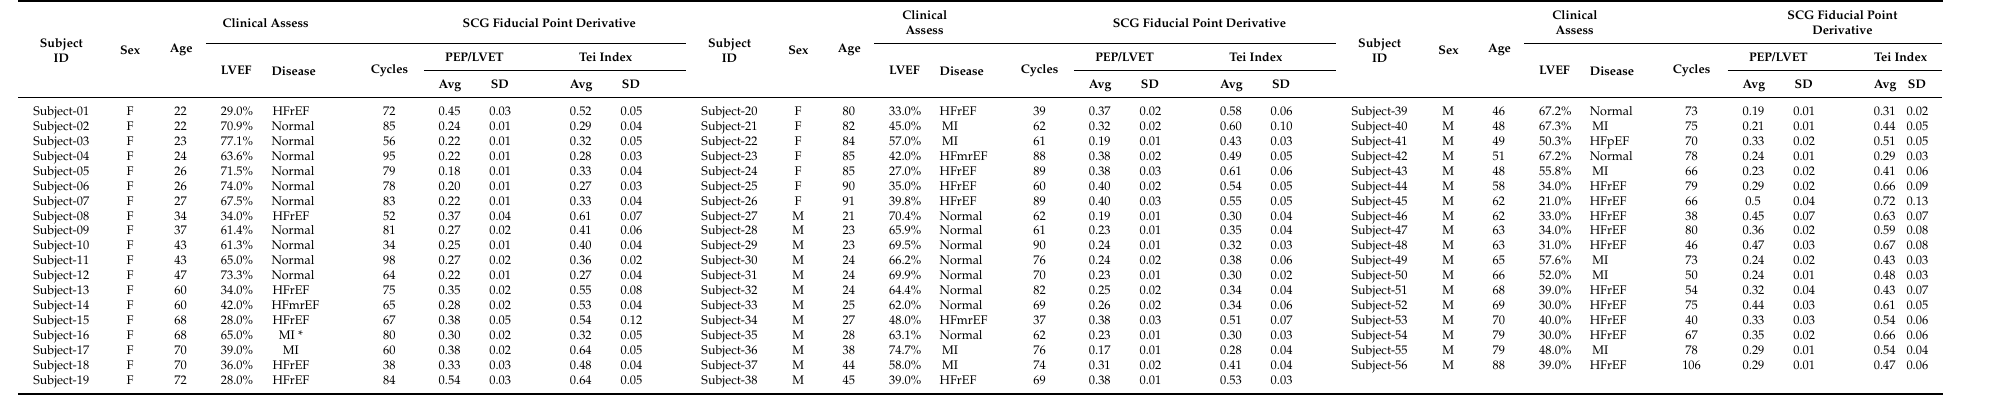
Table 1. Clinical assessment and SCG fiducial point derived cardiac parameters for GLM and ROC curve